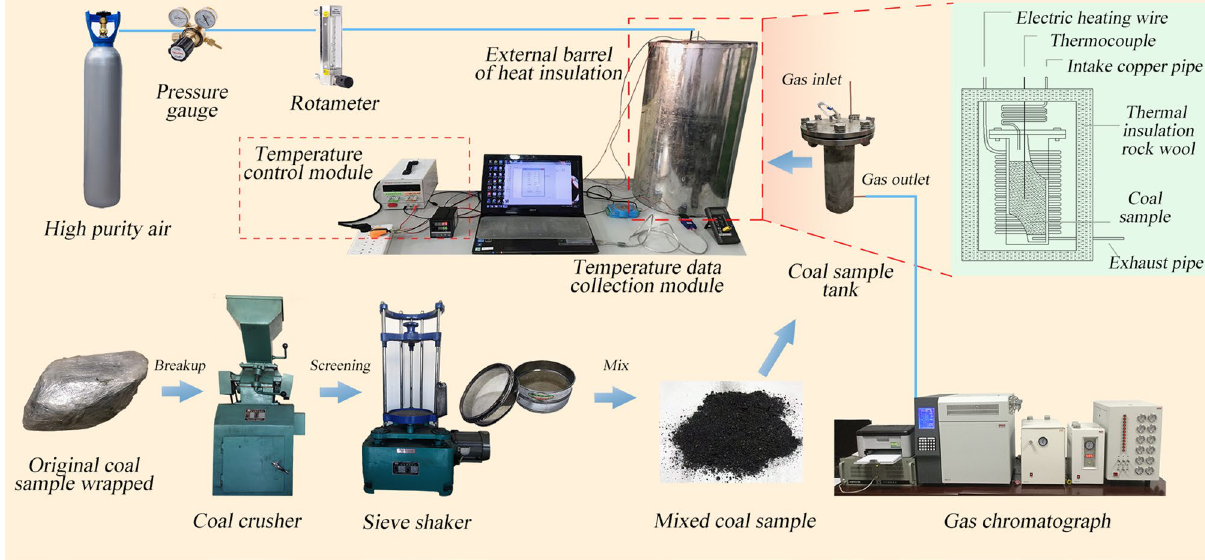
Figure 1. Temperature-programmed experimental system for coal